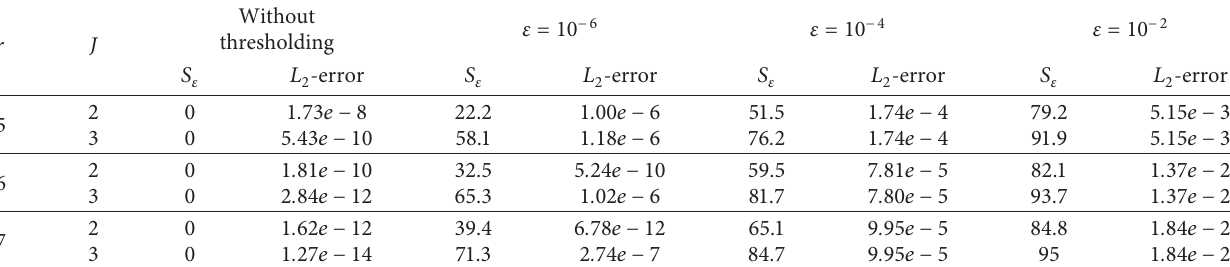
-error for Example 2